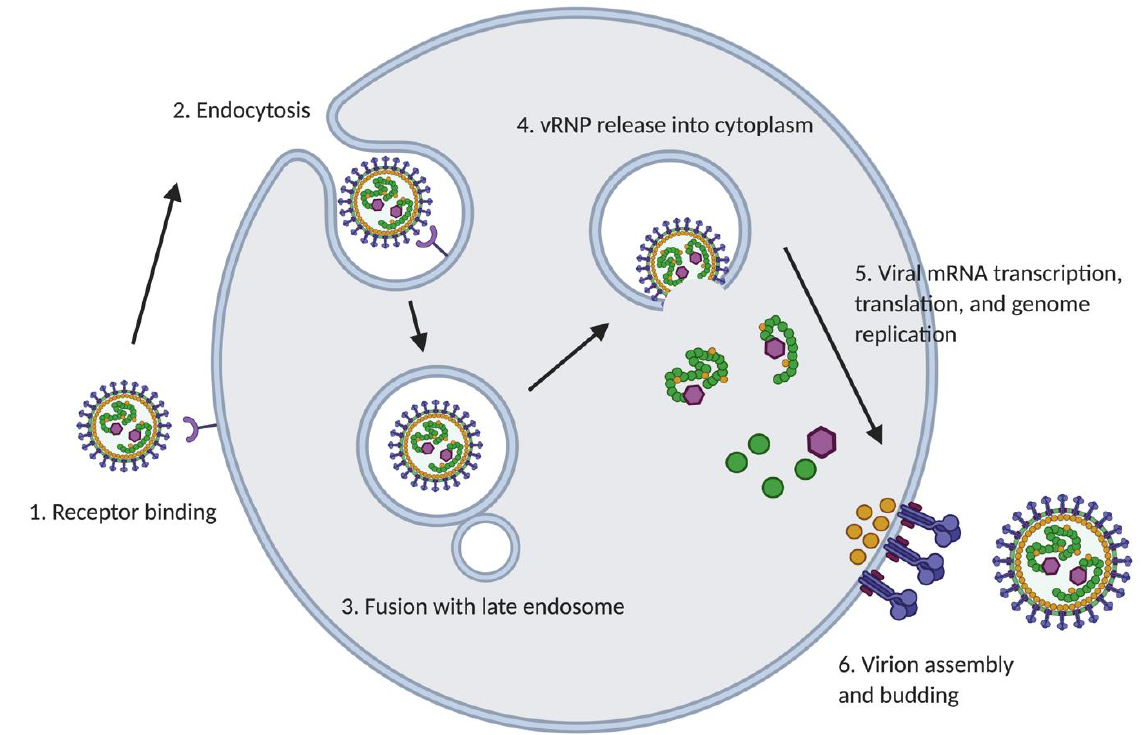
Figure 2. Mammarenavirus life cycle. Virus cell entry is initiated by the interaction between GP and different receptors present at the cell surface (1). Virus uptake into the cell is mediated by endocytosis (2). The acidic environment of the late endosome promotes fusion between viral and host cell membranes (3). Following the pH-dependent membrane fusion event, the vRNP is released into the cytoplasm, where it directs the biosynthetic processes of replication and transcription of the viral genome (4,5). Viral assembly takes place in the cell cytoplasm, and virions bud from the plasma membrane. Z plays critical roles in both these processes (6).